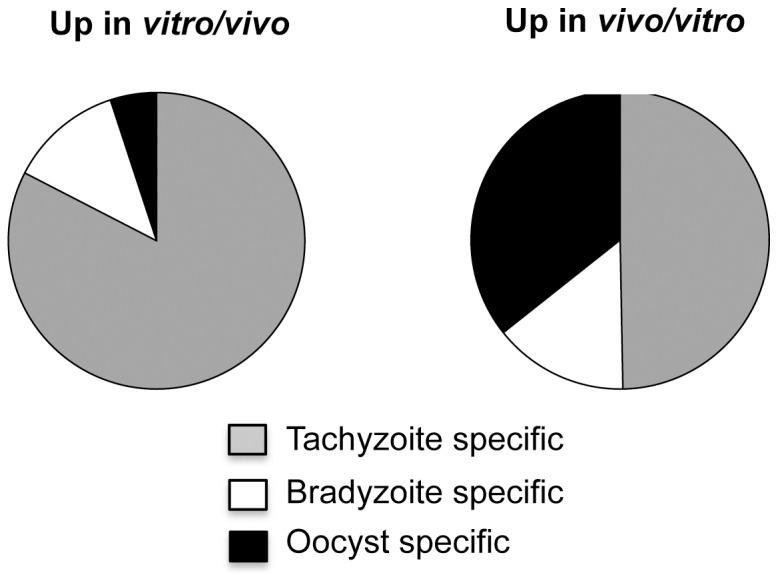
A disproportionate number of putative oocyst stage specific genes are increased in vivo in WT mice compared to in vitro in HFF cells.
T. gondii tachyzoite, bradyzoite and oocyst specific transcripts that were differentially expressed by T. gondii in vivo in WT mice versus in vitro in HFF cells For the comparison, stage specific genes were those that had EST data for only one stage of the parasite and/or at least a 10-fold preferential increase in the ToxoDB microarray data for a particular stage.